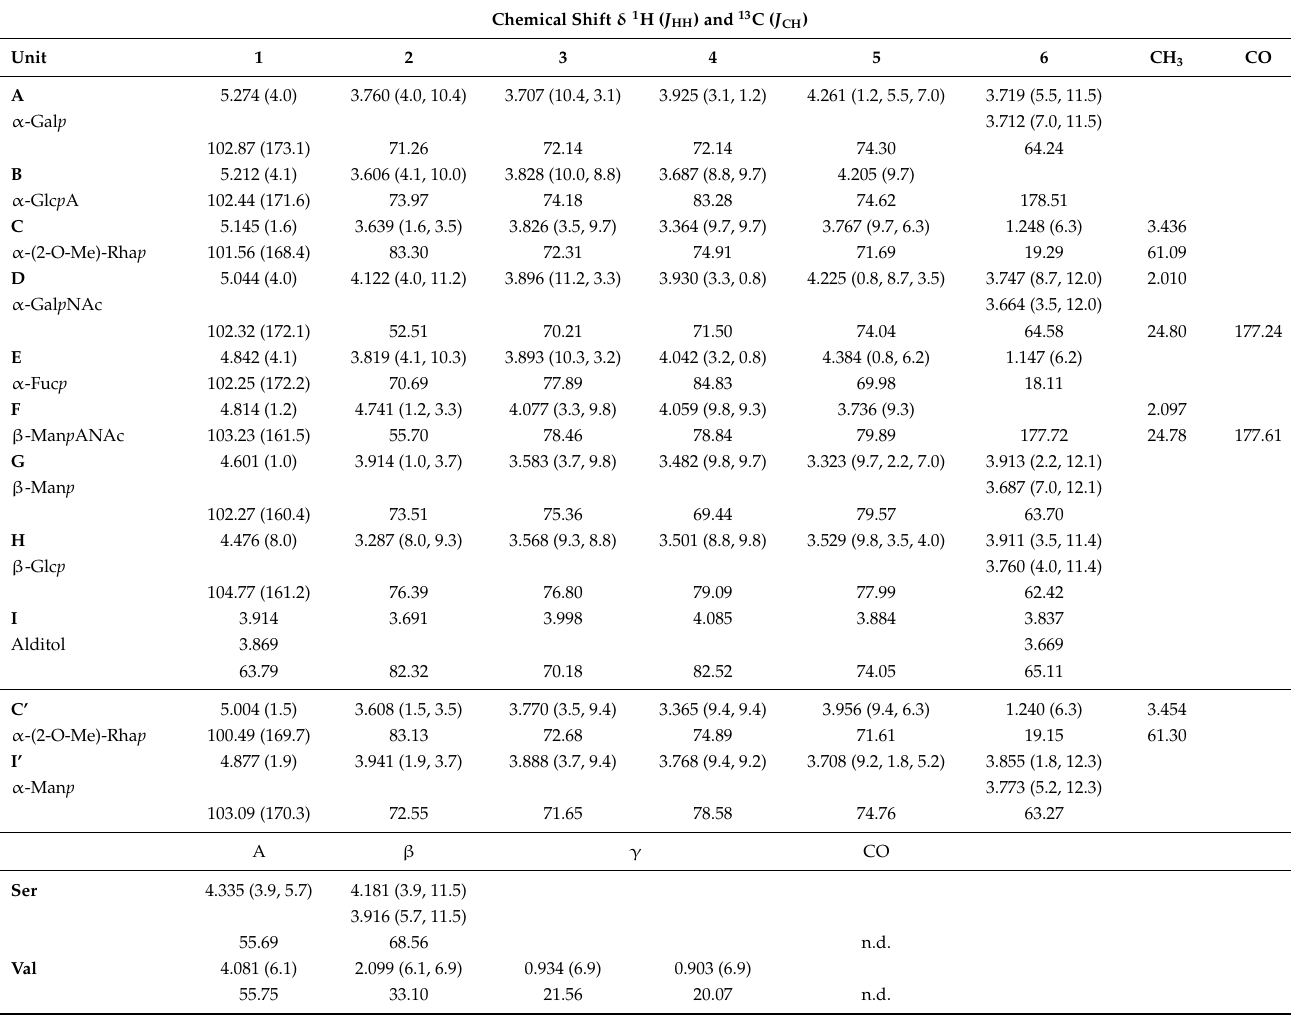
Table 2. 1 H and 13 C chemical shifts (ppm) and in parenthesis J couplings (Hz) of the nonasaccharide preparation from B. fragilis wild-type and the disaccharide glycopeptide from a B. fragilis ∆ BF4306 mutant. Chemical Shift δ 1 H ( J HH ) and 13 C ( J CH )